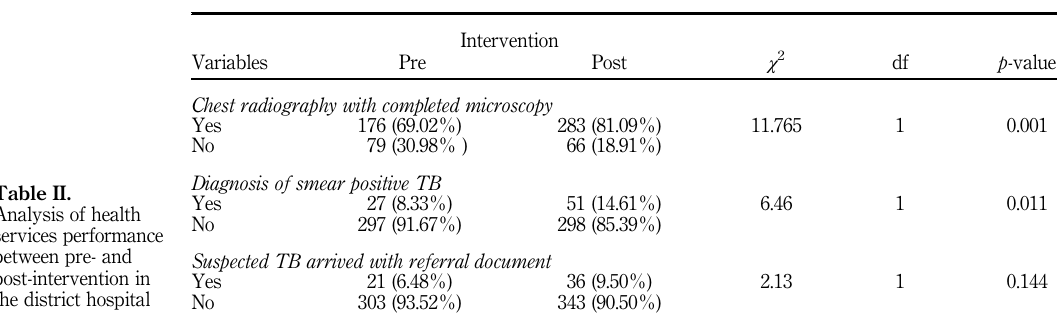
Table I. Characteristics of suspected TB cases and health service performance in district hospital